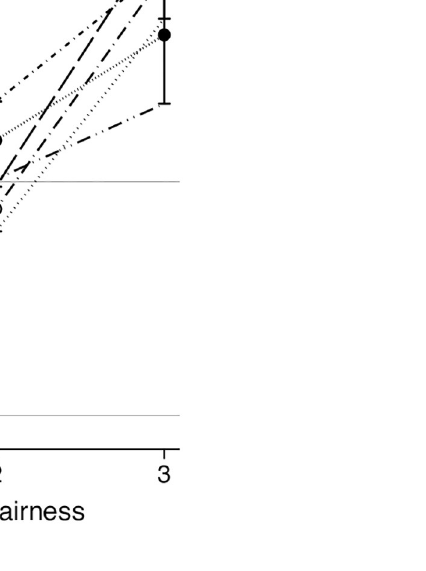
Fig 7. Contribution levels in different regimes by